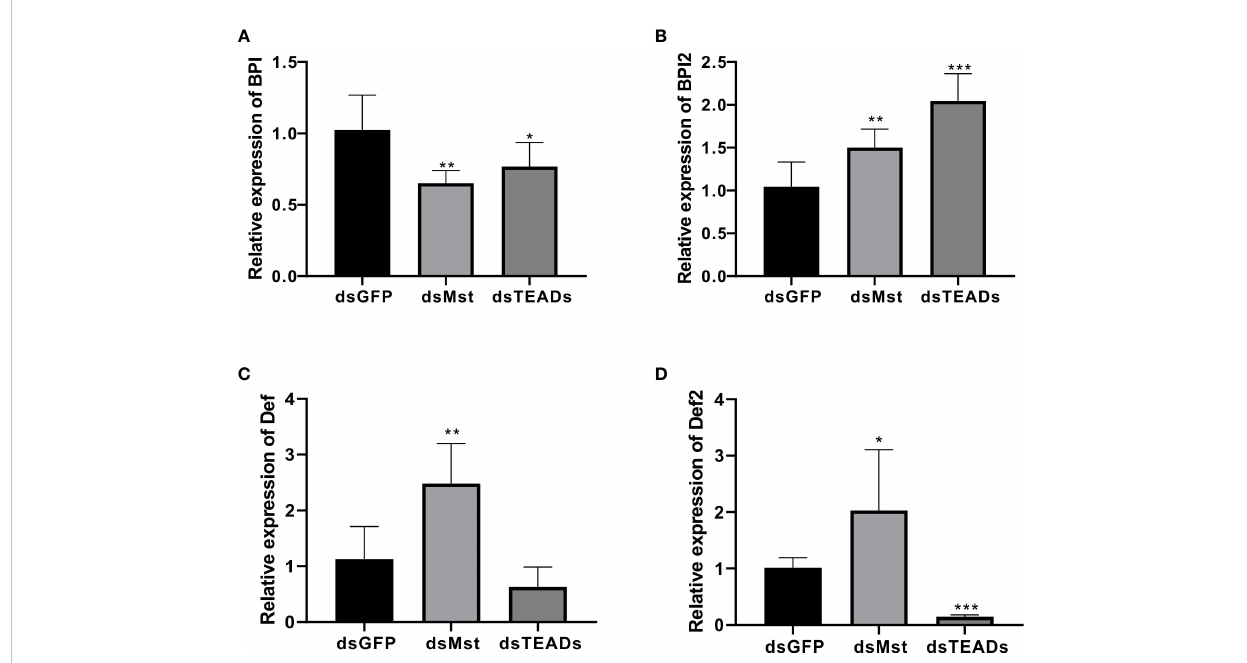
FIGURE 7 Responses of four immune-related genes to MST and TEAD gene silencing. The relative expression of BPI (A) , BPI2 (B) , Def (C) , and Def2 (D) in dsGFP, dsMst and dsTEADs groups was examined by qRT-PCR. Data analysis was performed by using GraphPad Prism 9 software, and vertical bars represent the mean ± SD ( n = 3). *** p < 0.001; ** p < 0.01; * p <